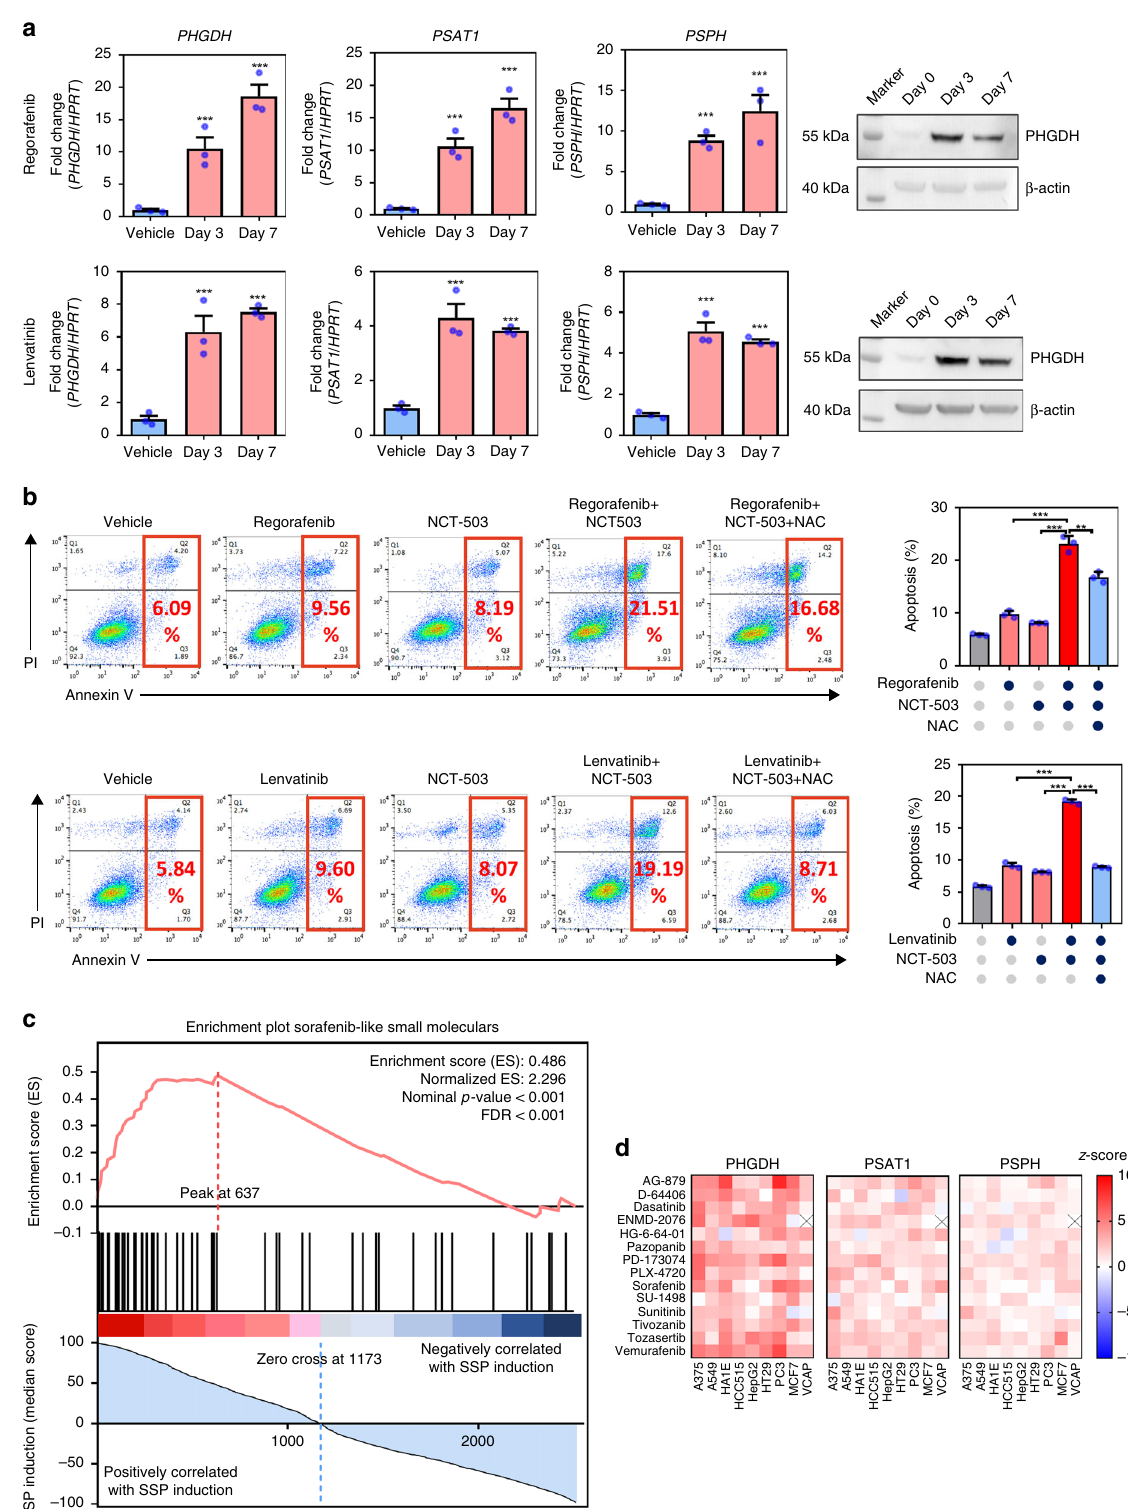
Fig. 6 PHGDH contributed to Regorafenib and Lenvatinib resistances in HCC. a Treatment of Regorafenib at 10 μ M and Lenvatinib at 40 μ M for 48 h induced PHGDH , PSAT1 , and PSPH expression in HCC cells. b Co-treatment of NCT-503 intensi fi ed Regorafenib and Lenvatinib-induced apoptosis in HCC cells, which can be rescued by addition of 5 mM NAC of 48 h treatment. c In total, 2514 compounds are ranked by their ability of inducing SSP in nine cell lines. The Sorafenib-like small molecules ( n = 52) were signi fi cantly enriched in the highly ranked SSP-inducible compounds as suggested by GSEA pre- ranked enrichment analysis. d Most of the Sorafenib-like small molecules profoundly induced the mRNA expression of PHGDH , PSAT1 , and PSPH in all cell lines. The error bar represents the SEM, n = 3 biological independent samples. Source data are provided as a Source Data fi le. (Student's t -test * P < 0.05, ** P < 0.01, *** P <